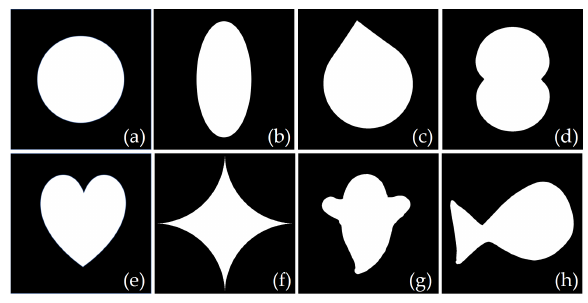
Figure 4. Set of shapes used as target for engineering intensity and phase gradient of light beams by estimating parametric equations; ( a ) ring, ( b ) ellipse, ( c ) droplet, ( d ) nephroid, ( e ) heart, ( f ) astroid, ( g ) ghost, and ( h ) fish.